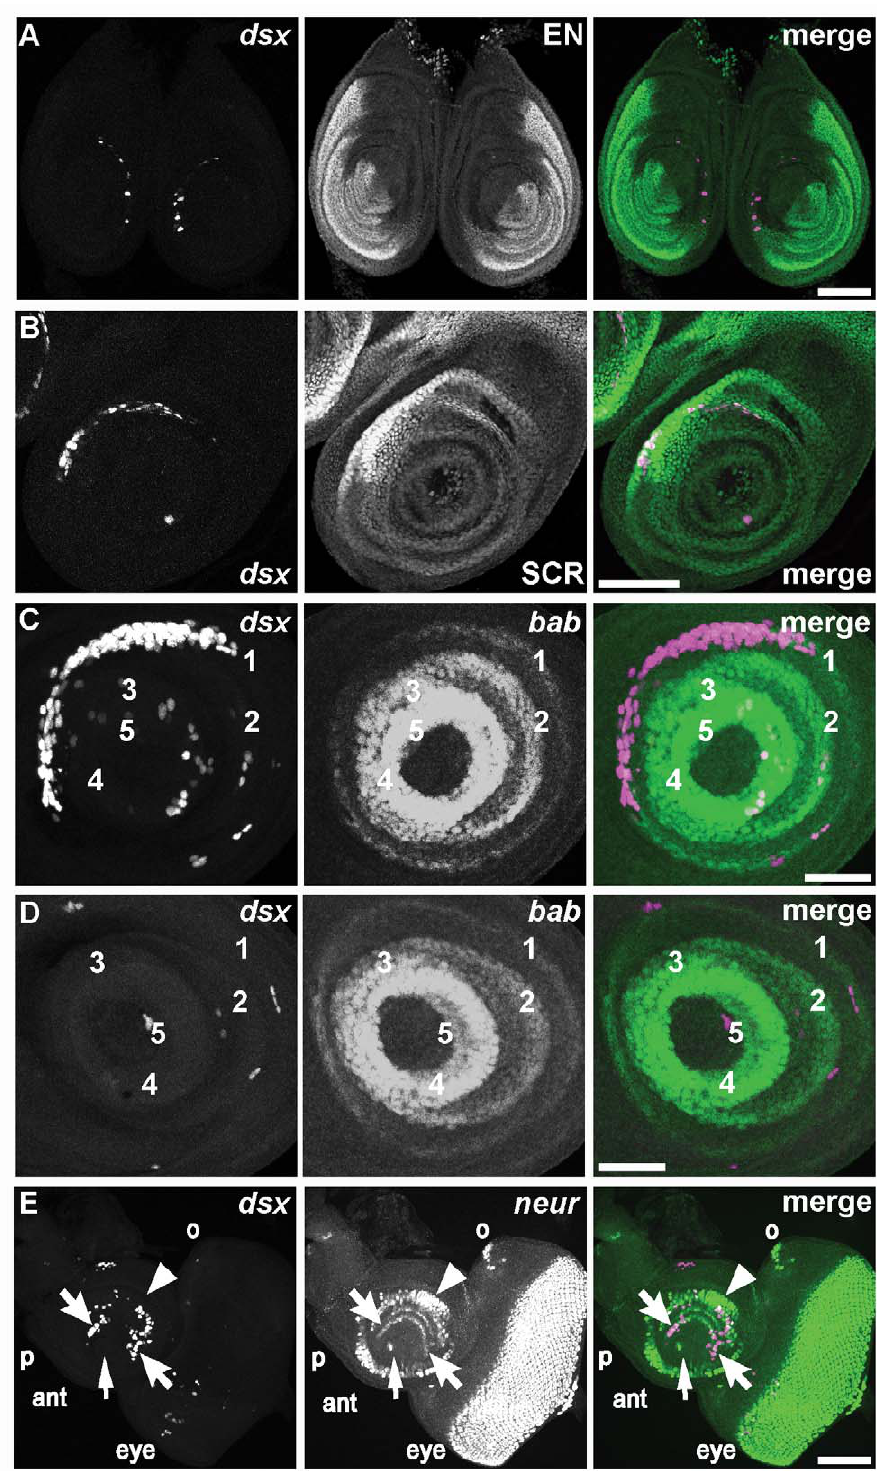
Figure 4. dsx GAL4 is expressed in imaginal discs. Fluorescence of indicated reporters in imaginal discs of third instar female larvae is shown. (A) dsx GAL4 driving expression of UAS-Stinger nuclear GFP reporter (magenta) is compared to the posterior compartment of the disc marked by EN (green) in this pair of foreleg discs from an early wandering third instar larva. At this stage, few cells express dsx GAL4 , but the majority of these cells form a broken crescent within the anterior compartment. Scale bar, 100 m m. (B) Expression of UAS-Stinger nuclear GFP reporter (magenta) in the foreleg disc is compared to the position of tarsal and tibial primordia that express high levels of SCR (green). In this disc from a more mature wandering third instar larva than shown in (A) there are more expressing cells in the dsx GAL4 crescent, and the crescent overlaps with the SCR domain. Scale bar, 100 m m. (C) Expression of UAS-RedStinger nuclear DsRed reporter (magenta) is compared to the position of tarsal segment boundaries defined by